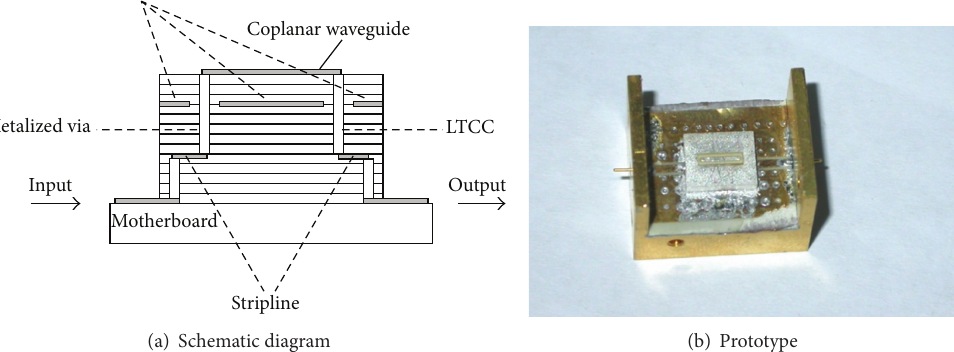
Figure 11: Transition from planar waveguide to stripline based on LTCC